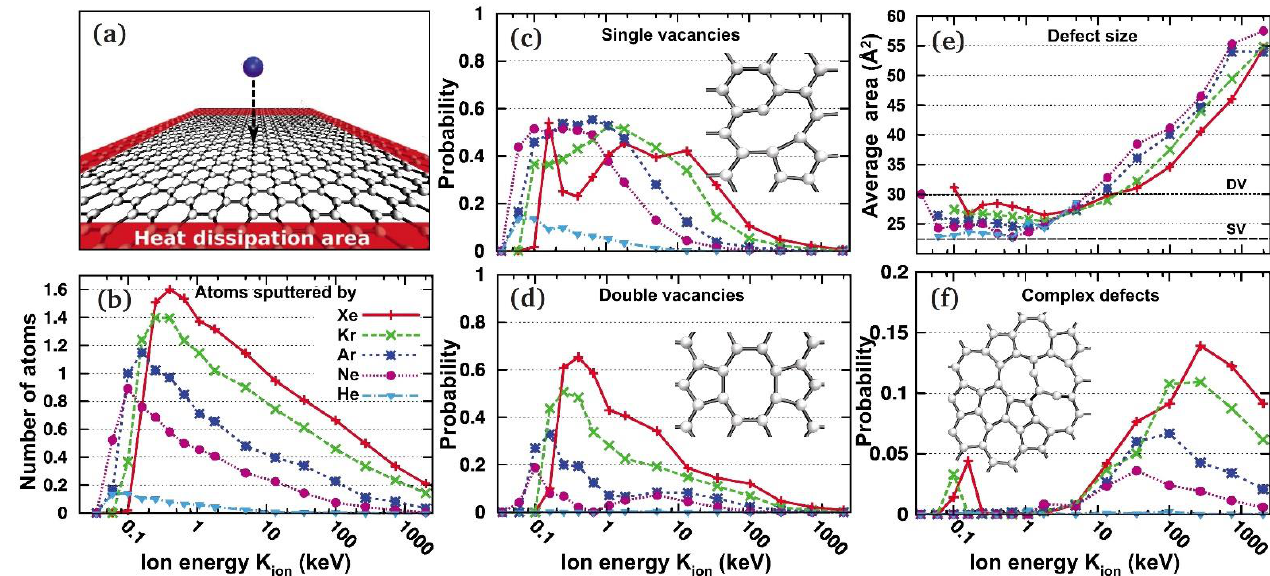
Figure 5. Production of defects in graphene under ion irradiation as revealed by the analytical potential molecular dynamics. ( a ) Simulation setup. ( b ) The number of sputtered atoms per ion impact as a function of ion energy. ( c , d ) Probability for single and double vacancy formation as a function of ion energy. The insets show the atomic structures of the reconstructed vacancies. ( e ) Average area covered by a single defect (when formed) — typically still an sp 2 -bonded network of carbon atoms. The areas corresponding to an SV and DV are marked. ( f ) Probability for creating defects other than SV/DV. Taken with permission from Ref. [18]. Copyright by APS.